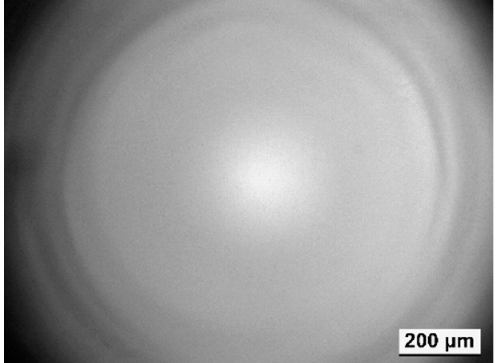
Figure 4. Typical coefficient of friction vs distance record.